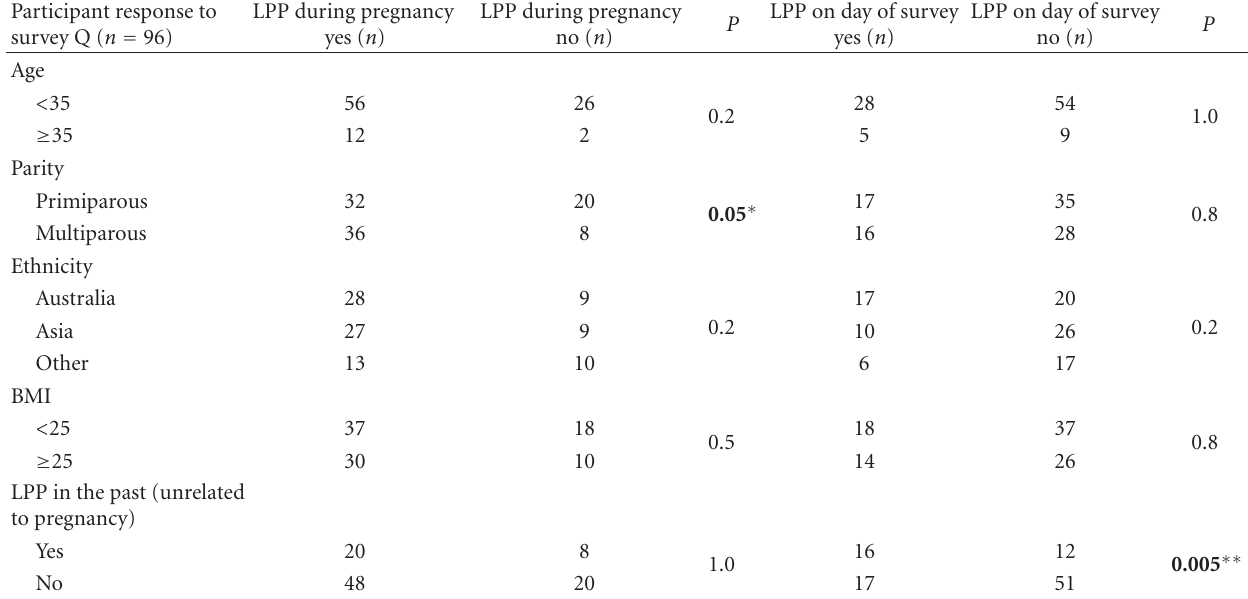
Table 2: LPP and participant characteristics.